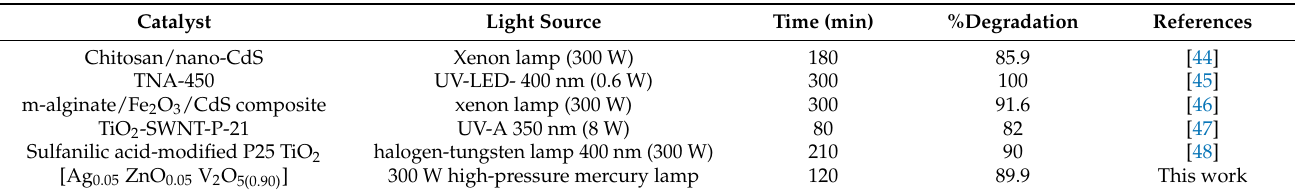
Table 2. Comparison of the photocatalytic disposal of Congo red dye over various catalysts.